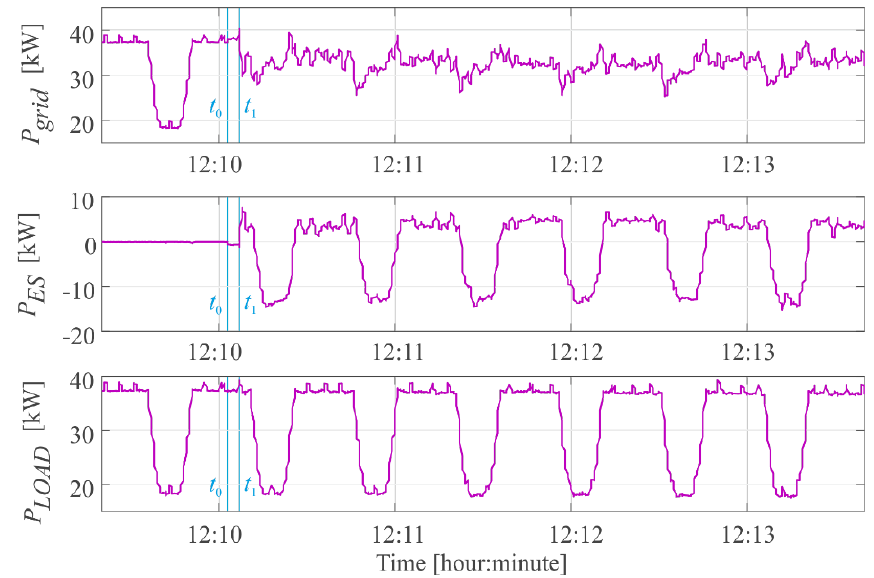
Figure 5. Time waveforms of the grid power P grid , power of the energy storage P ES and load power P LOAD during the operation of the power stabilization algorithm of unstable loads with energy storage prototype.